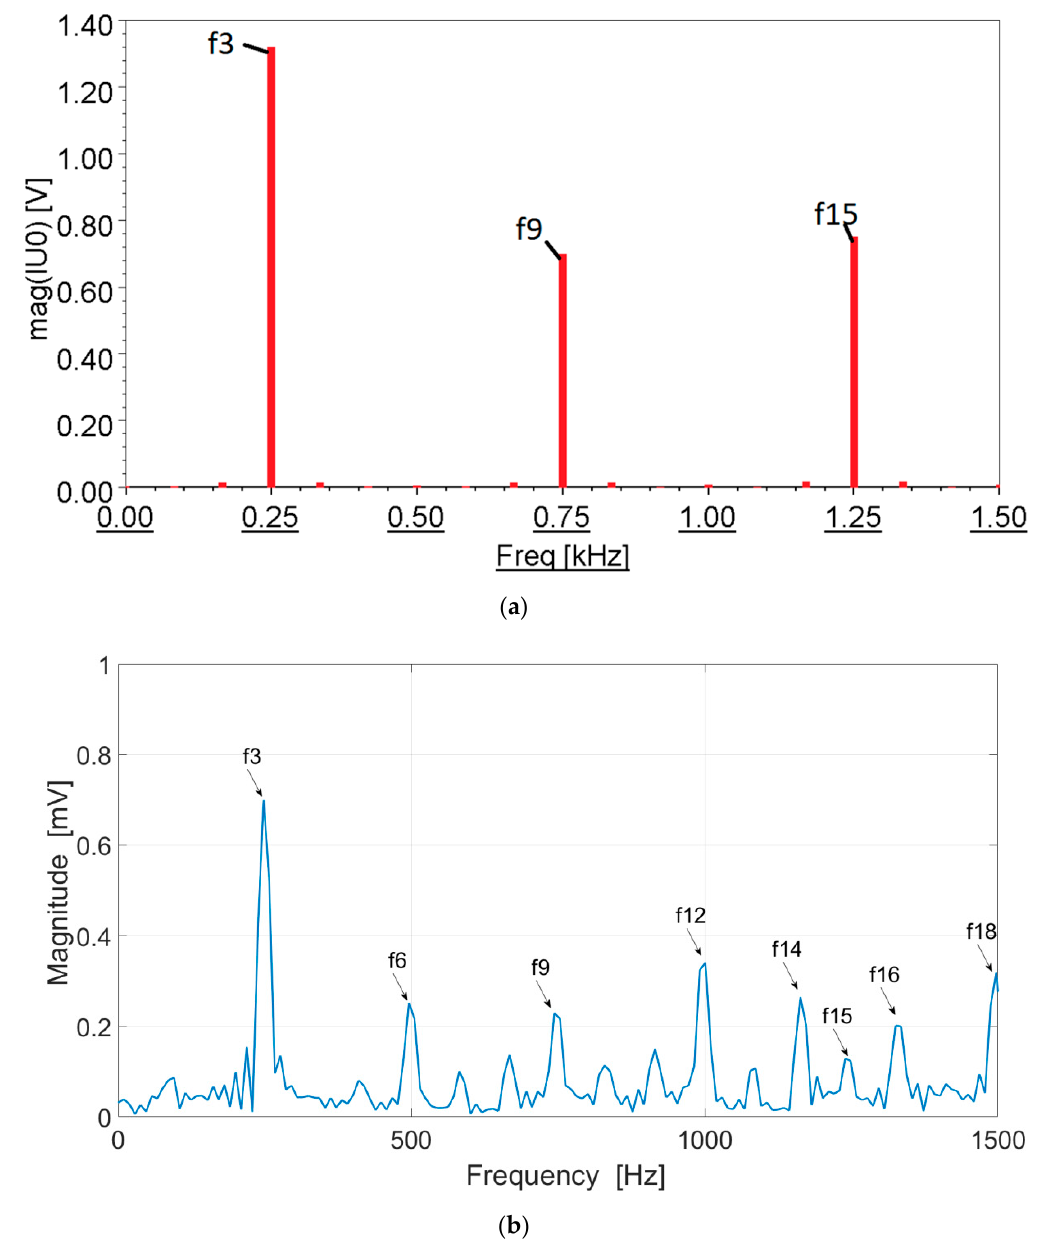
Figure 21. Star–delta (Y ∆ ) configuration—FFT of neutral voltage u 0 in healthy mode: ( a ) numerical calculations; ( b ) measurements.